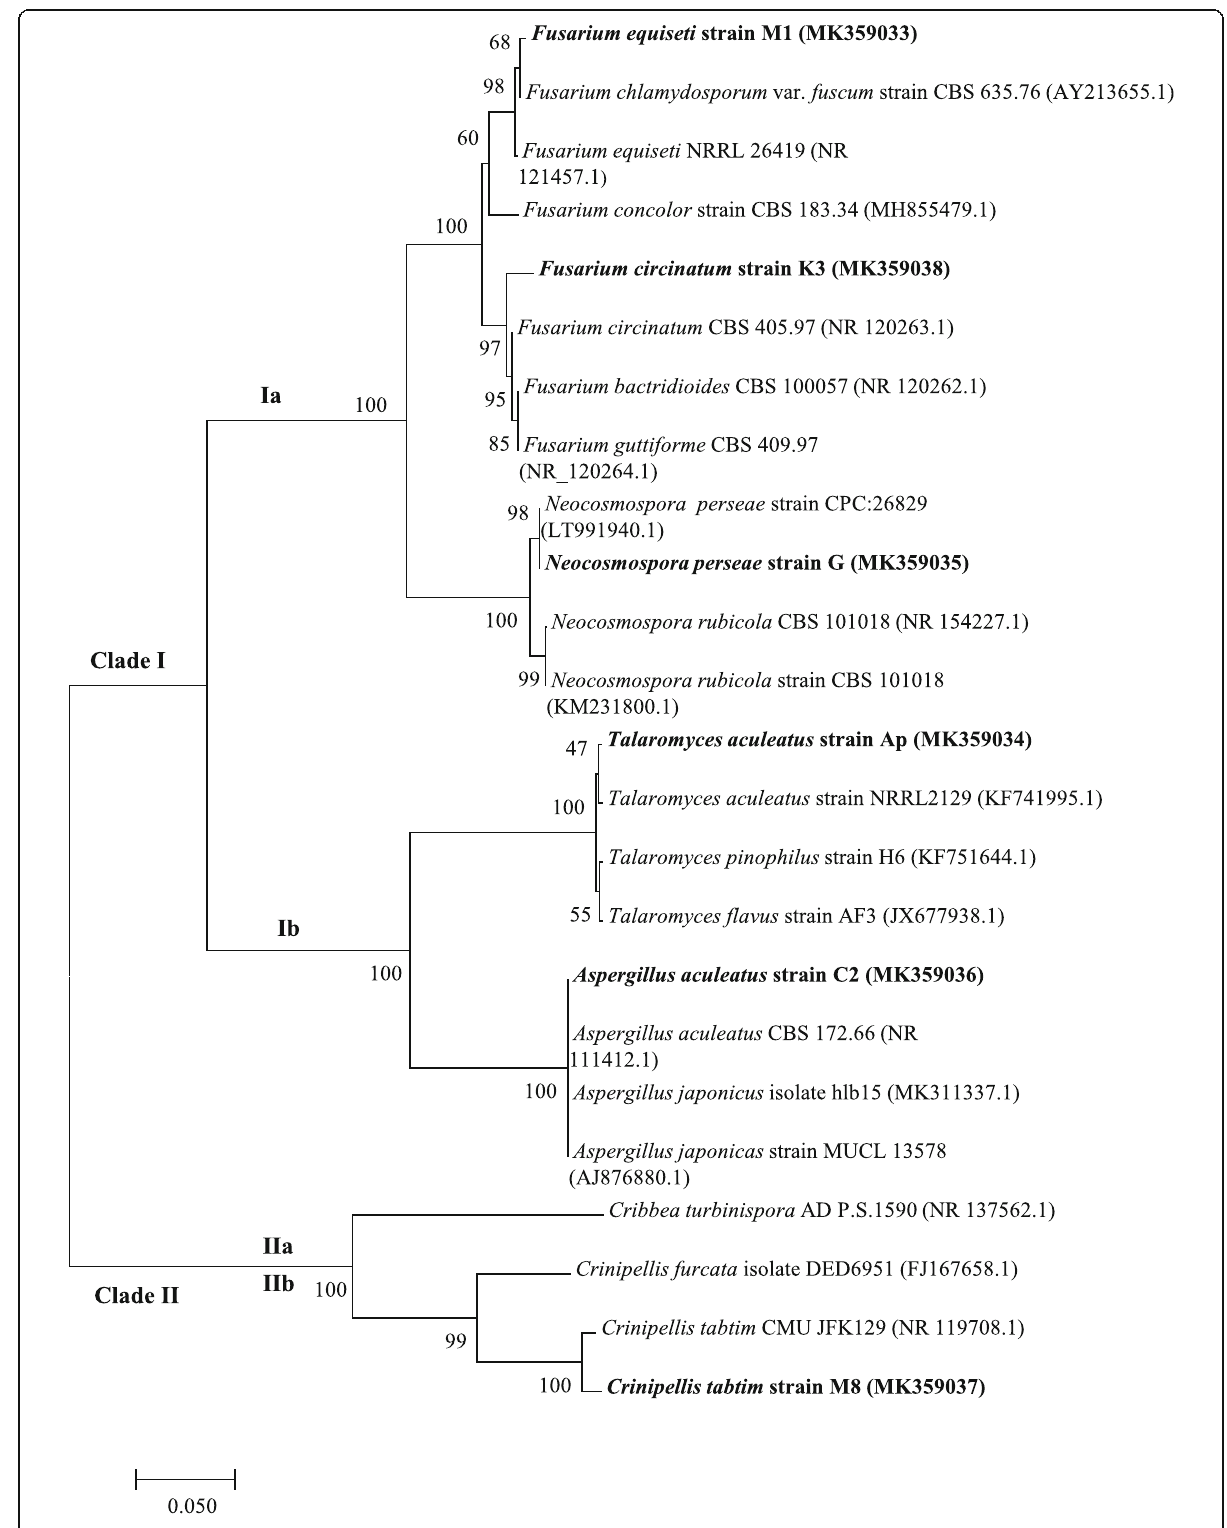
Fig. 1 Phylogenetic tree based on the ITS sequences drawn using neighbor-joining method showing relationship between the 6 isolates of fungal root endophytes and similar other sequences deposited in the NCBI GenBank, USA. Evolutionary analyses were operated in MEGA